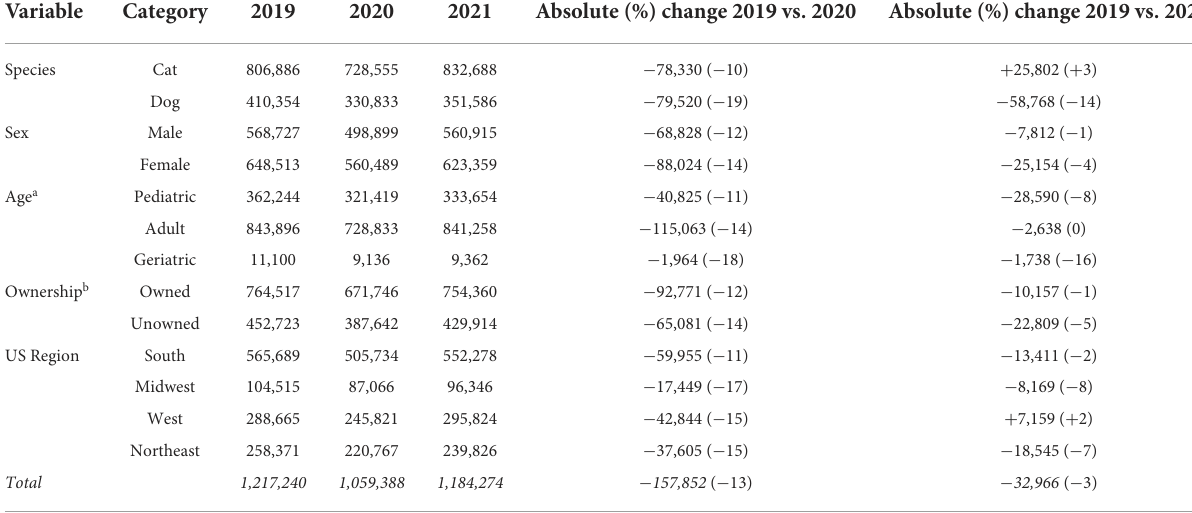
TABLE 2 Number of cats and dogs spayed or neutered, by species, sex, age, ownership status, and US regions in 2020 and 2021 compared to the baseline year of 2019.